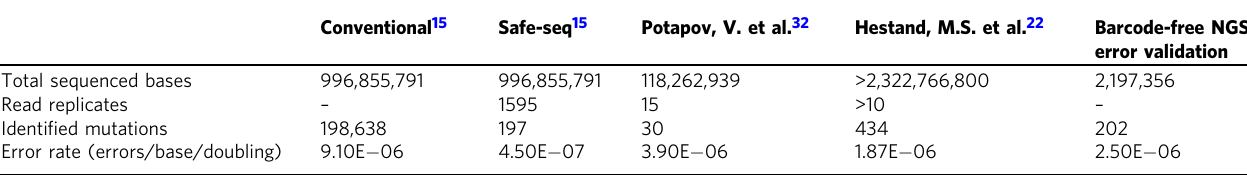
The barcode-free NGS error validation can use NGS reads more ef fi ciently at least 10 times compared to the previous reports 15,22,32 , since this method does not require read replicates for barcoding. Total sequenced bases represents the bases used to measure variants occurred during PCR with Phusion polymerase. Reads replicates represents the number of read replicates used to fi lter